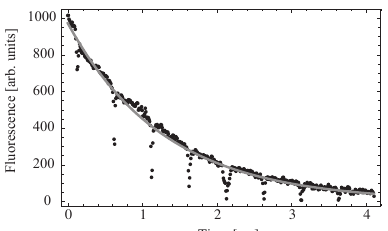
Figure 14. Intensity of fluorescence due to an electron beam sweeping across the screen of a line triggered oscilloscope recorded by a shutter-controlled CCD camera. The dips in intensity correspond to the grid lines on the oscilloscope. The spacing between the grid lines is determined by the time base setting of the oscilloscope, thereby allowing the pixel axis to be converted to a time scale. The solid curve is the best fit to the data based on a decaying exponential. The fit gives a decay time of 1.30 ± 0.03